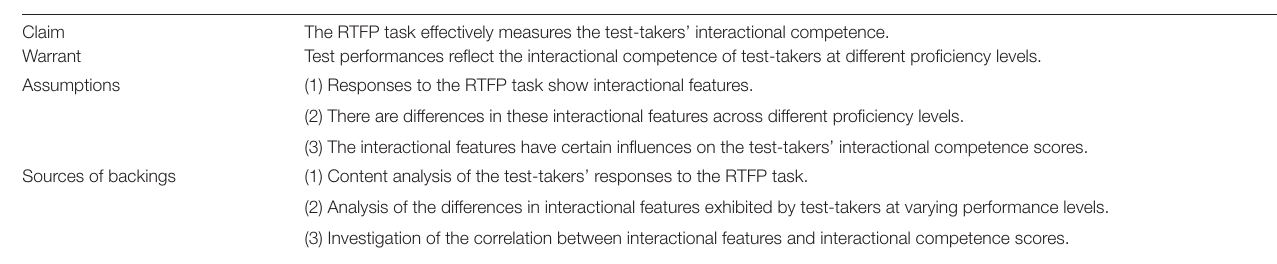
TABLE 1 | The argument-based validation framework for the RTFP task. Claim The RTFP task effectively measures the test-takers’ interactional competence. Warrant Test performances reflect the interactional competence of test-takers at different proficiency levels.